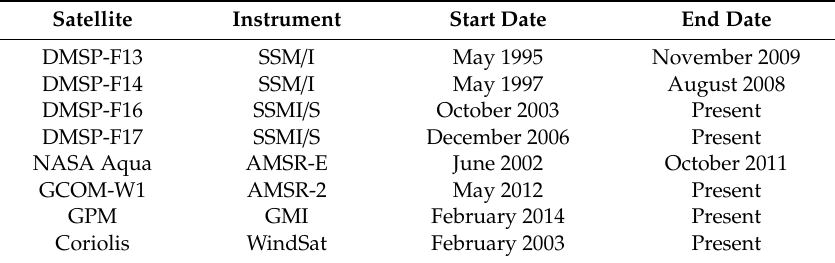
Table 1. Satellite instruments used in the article.